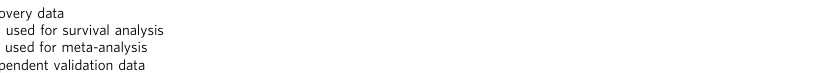
d Independent validation